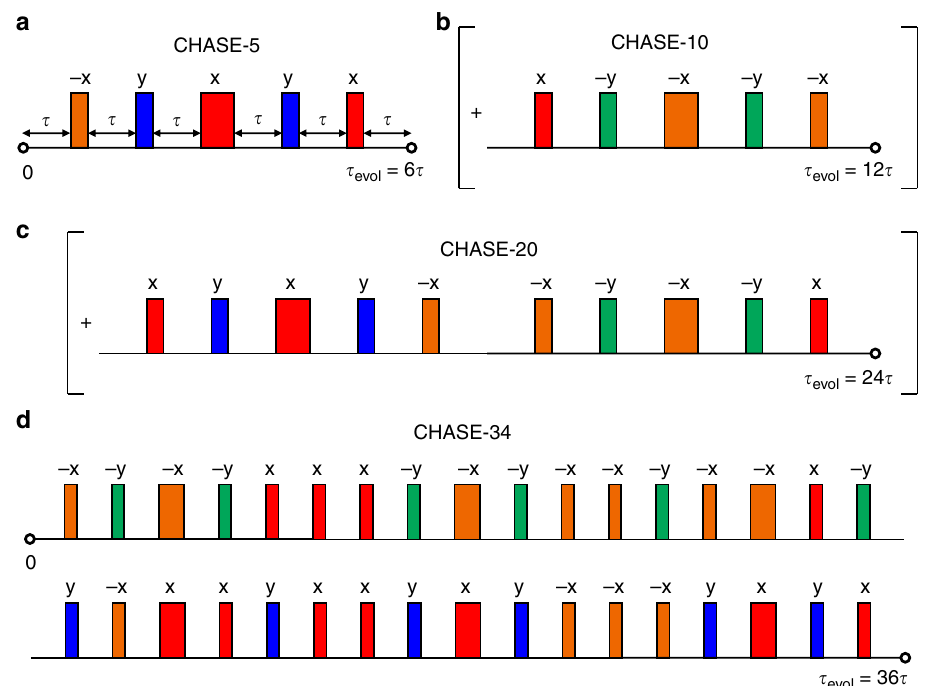
Fig. 1 Pulse sequences for refocusing inhomogeneous and dipolar broadening. a The combined Hahn and solid echo sequence CHASE-5 with cycle time t = 3 t π + τ t π and total free evolution time τ = 6 τ (where τ ≫ t π is the free evolution time between two pulses). c evol consisting of the total gate time 3 evol b Extension to CHASE-10, which is less sensitive to fi nite pulse durations t π > 0. c Using symmetry considerations, a further optimised sequence CHASE-20 is constructed. d The longest sequence CHASE-34 with a total gate time 20 t π has the best refocusing capability for t π → 0. The radio frequency (rf) carrier phases are φ x = 0, φ − x = π for ±x rotations around the ^ e axis and φ y = π /2, φ − y = 3 π /2 for ±y rotations around ^ e . Narrow pulses indicate π /2-rotations x y with pulse time t π /2 and broad pulses correspondingly represent π -rotations with duration t